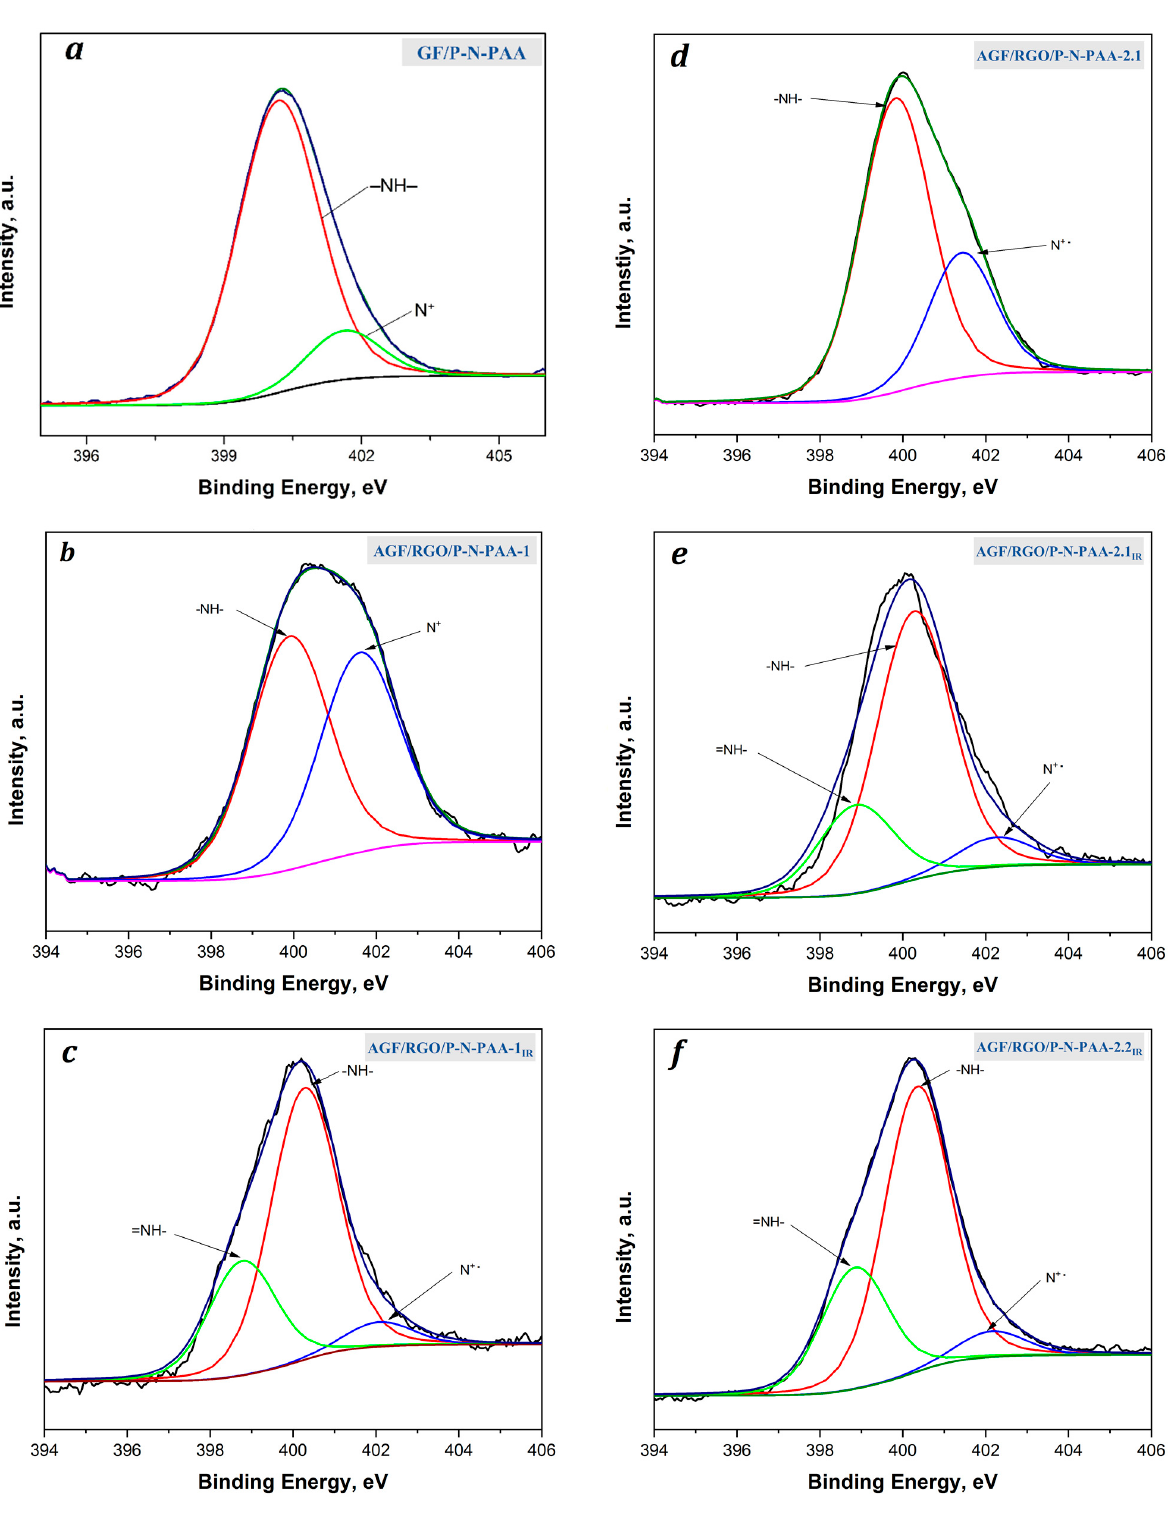
Figure 8. N1s XPS spectra of GF/P-N-PAA-1 ( a ) and AGF/RGO/P-N-PAA before ( b , d ) and after IR heating ( c , e , f ).